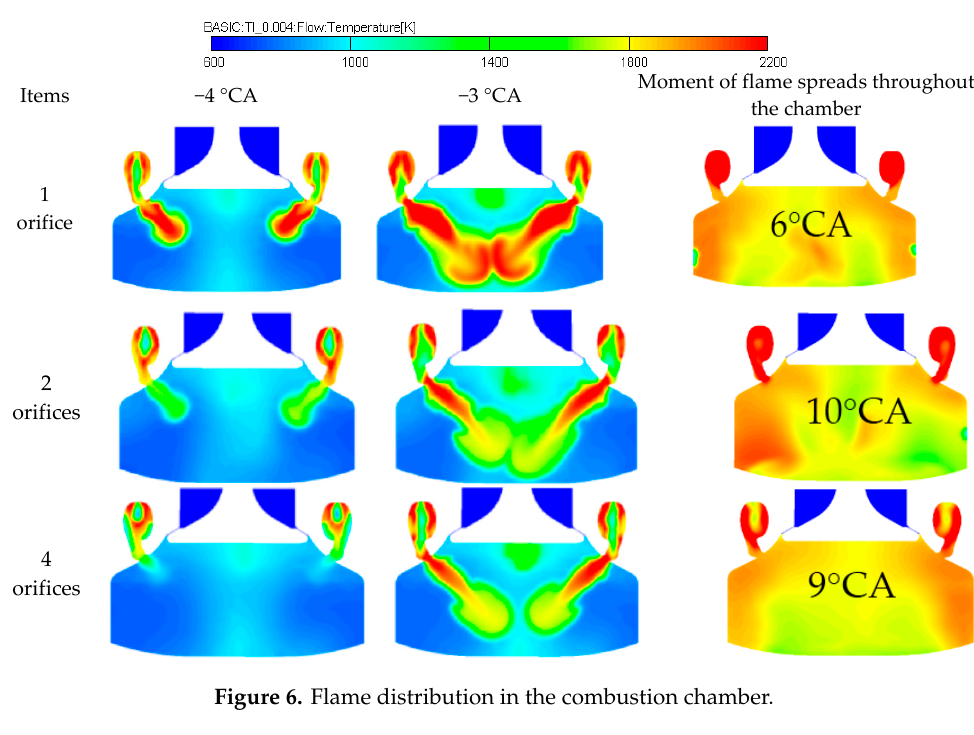
Figure 6. Flame distribution in the combustion chamber.